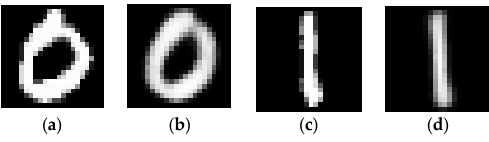
Figure 17. Examples of original and encoded images. ( a ) Example of a digit after preprocessing; ( b ) Decoded image from 24 values into 484. Same image as in (a); ( c ) Another example of a digit after preprocessing; ( d ) Decoded image from 24 values into 484. Same image as in (c).